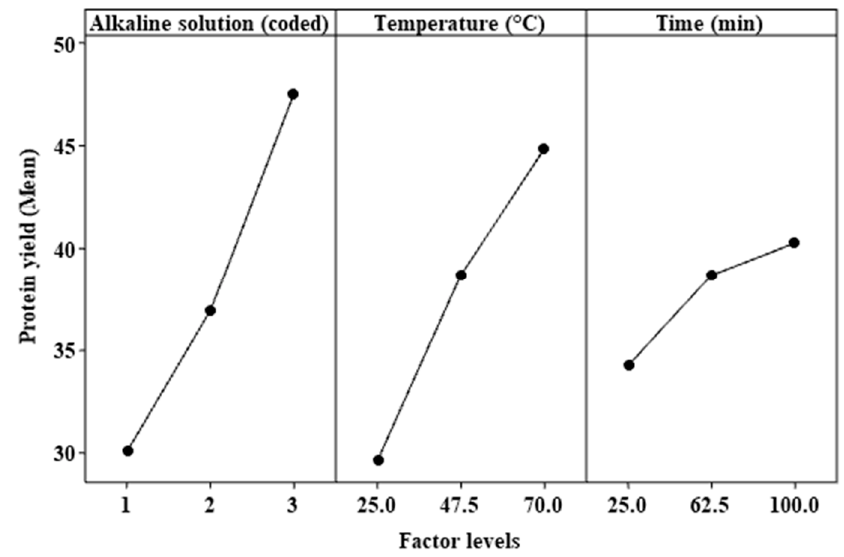
Figure 2. Main effects of factors for protein yield (%).